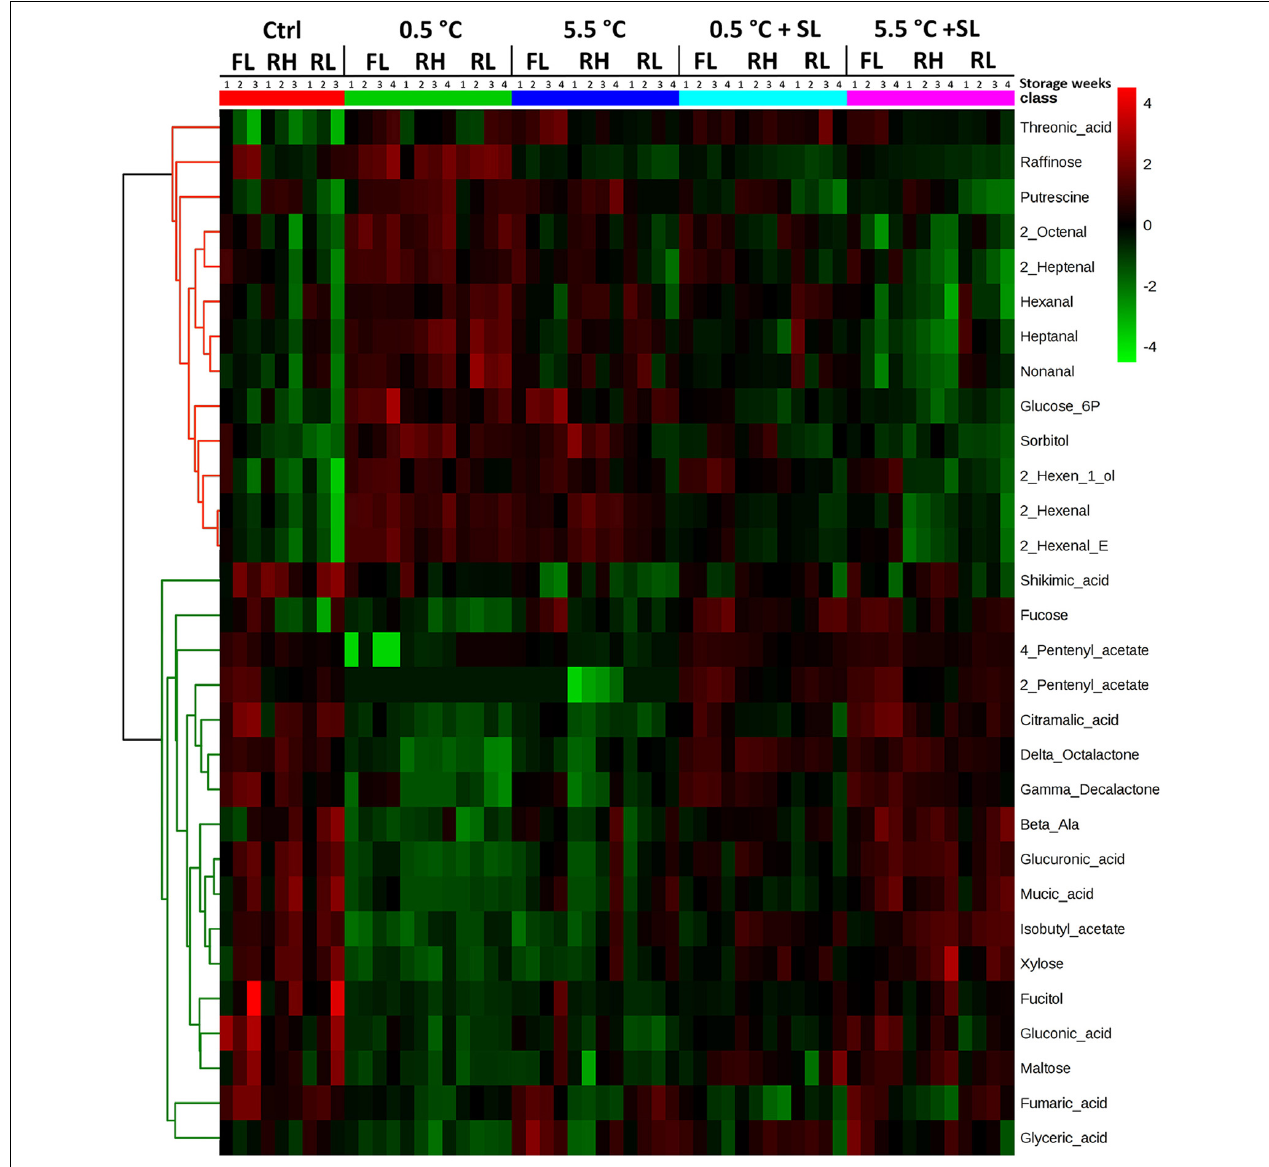
FIGURE 6 | Heatmap analysis showing the fold change of top 30 compounds, sorted via ANOVA test ( p ≤ 0.05), contributing to the separation of the different treatments (both at the end of cold storage and after shelf-life, SL). Samples from all the tested conditions have been included in the analysis. Each column representing the specific cultivar (‘Red Haven’, RH, ‘Regina di Londa’, RL, and ‘Flaminia’, FL) is divided in sub-columns, one for each storage week (up to 3 or 4 for control and cold stored samples, respectively): each cell represents the average of three biological replicates. The correlation coefficients employed in order to group the different features were calculated by applying Pearson correlation using average as clustering algorithm. In this analysis features have been auto-scaled (mean-centered and divided by the standard deviation of each variable) in order to better visualize differences between treatments. Relative level of each compound was normalized separately for each cultivar on its amount at harvest (T0) in order to get information on compound levels along time. The color scale from green (–4) to red (4) is proportional to the compounds amount, given as relative fold change. The fold change was calculated using the formula: FC = –log 2 [mean(T0)/mean (T1, T2, T3, or T4)], where T from 0 to 4 is the relative intensity of each compound after 0, 1, 2, 3, or 4 weeks of storage, with or without a SL period depending on the specific